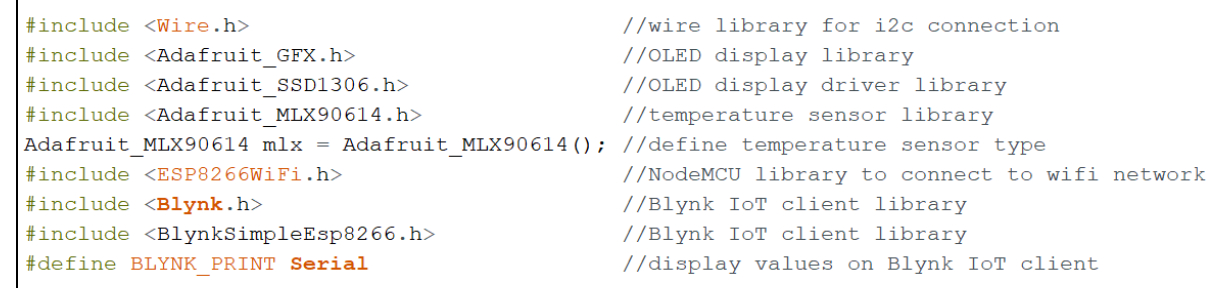
Figure 7. Including the relevant libraries in the Arduino sketch.